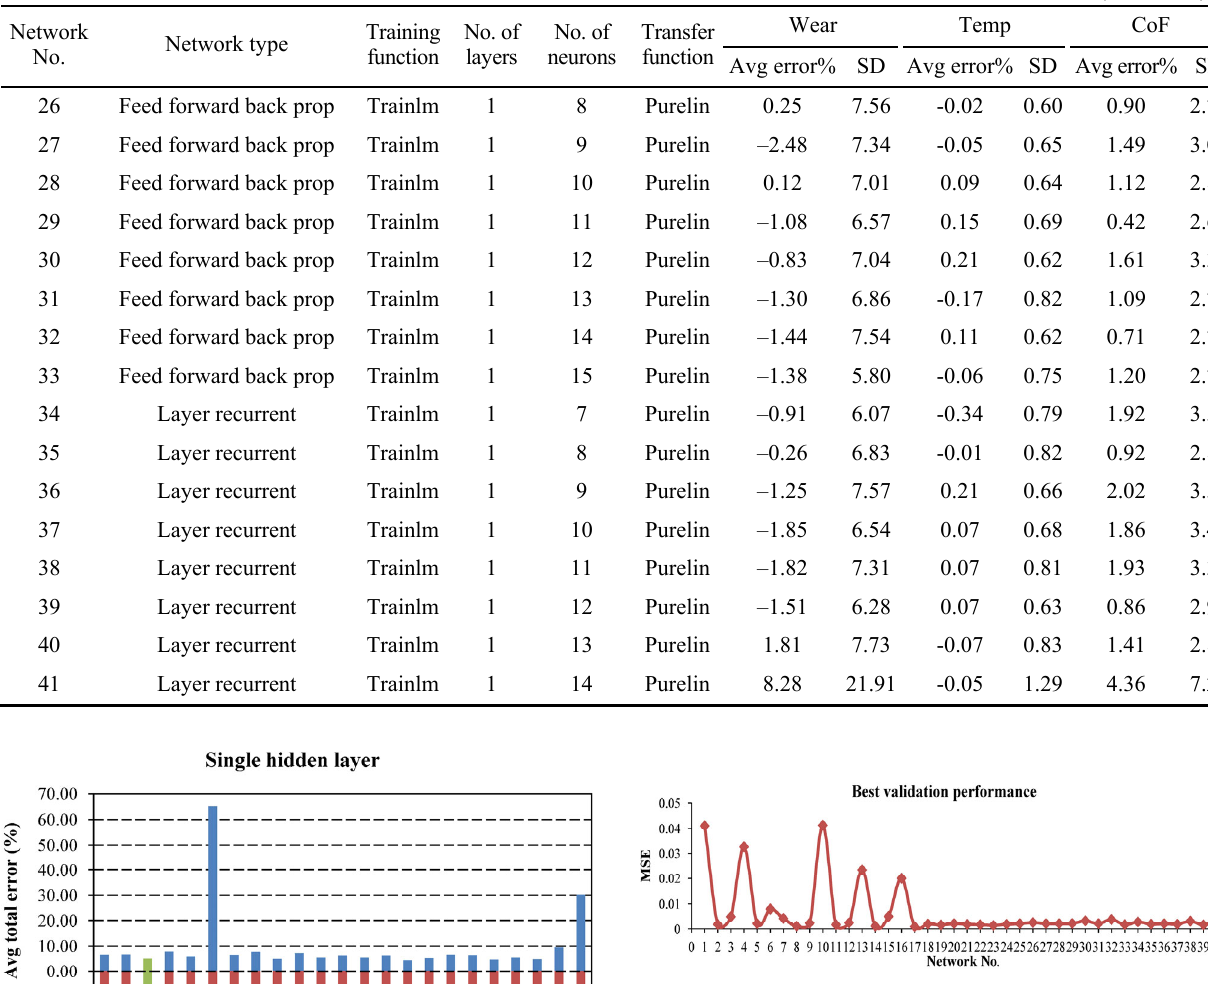
Fig. 13 Mean square error of SHL- ANN architecture (Network